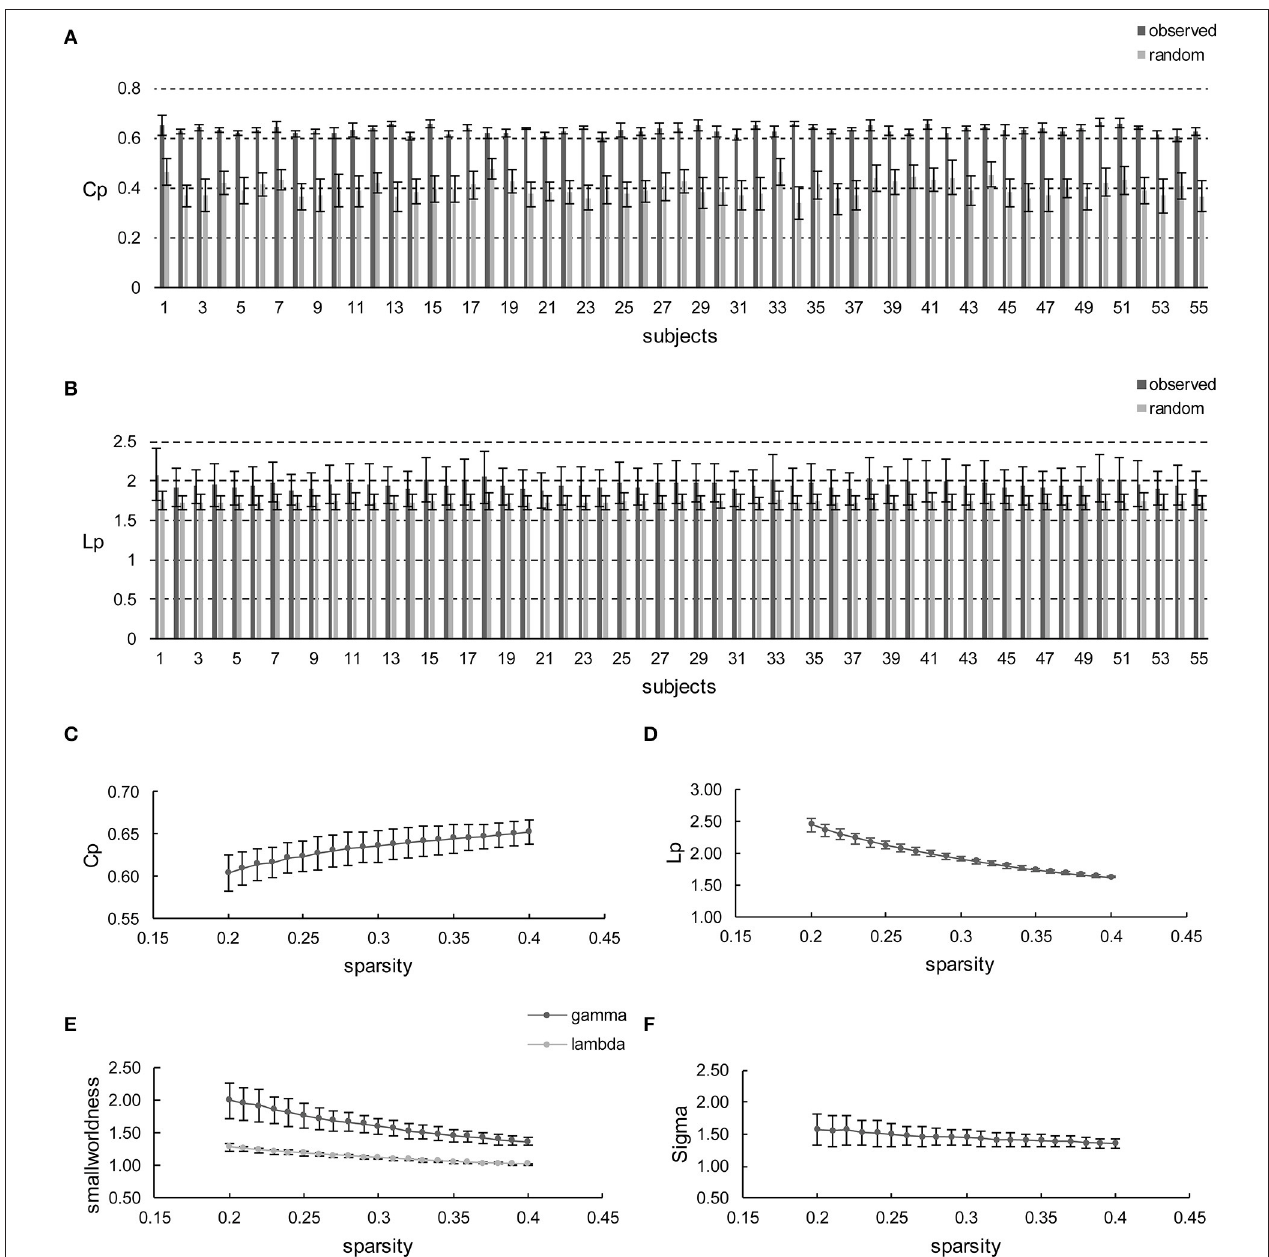
FIGURE 2 | Small-world configurations of the individual-based morphological networks. (A,B) Represent the average C p and L p of sparsities for each subject. The error bar indicates the deviation caused by different sparsities. (C–F) Show the average C p , L p , γ , λ , and σ of the subjects for each sparsity (from 20 to 40% with a step size of 1%). The error bar indicates the deviation caused by different subjects.